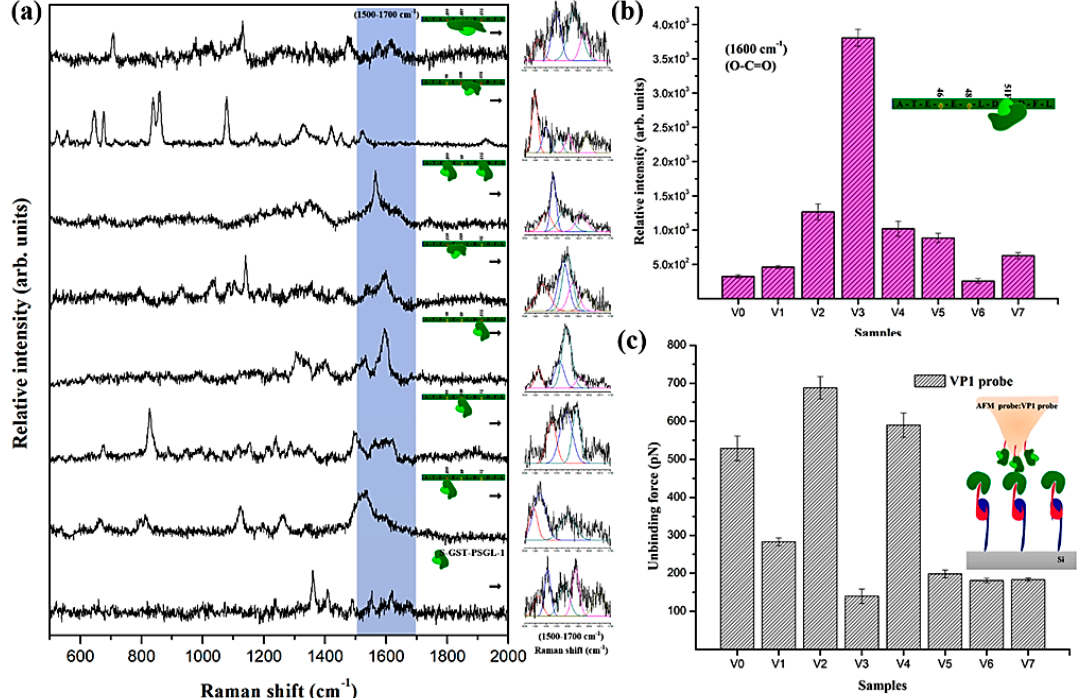
Figure7. TheSERSspectraofGST-PSGL-1mutantandVP1proteinsofenterovirus71(EV71)interactions Figure 7. The SERS spectra of GST-PSGL-1 mutant and VP1 proteins of enterovirus 71 (EV71) interactions on the SAM-modified Au nanoporous surface were examined at a Raman laser on the SAM-modified Au nanoporous surface were examined at a Raman laser wavelength of 633 nm. wavelength of 633 nm. ( a ) Marked SERS bands at 1500–1700 cm − 1 are highlighted. ( b ) The ( a ) Marked SERS bands at 1500–1700 cm − 1 are highlighted. ( b ) The relationships of the relative relationships of the relative Raman intensities for various mutant proteins and VP1 interactions on Raman intensities for various mutant proteins and VP1 interactions on Au nanoporous substrate were Au nanoporous substrate were determined using the I SERS peak region at 1600 cm − 1 . ( c ) The determined using the I SERS peak region at 1600 cm − 1 . ( c ) The unbinding force of VP1 probe unbinding force of VP1 probe V0~V7.